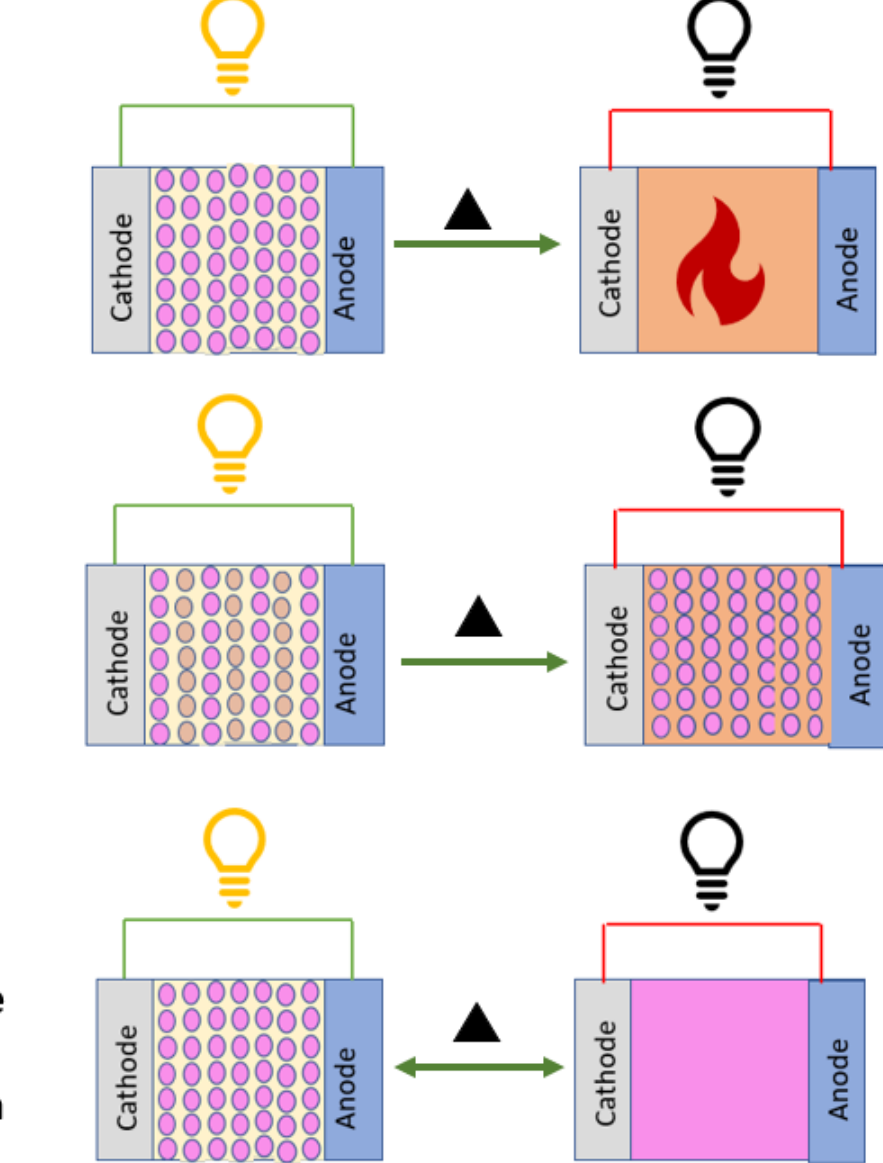
Figure 5. Schematic of thermal shutdown, irreversible thermal shutdown, and reversible thermal shutdown mechanism in energy storage systems.